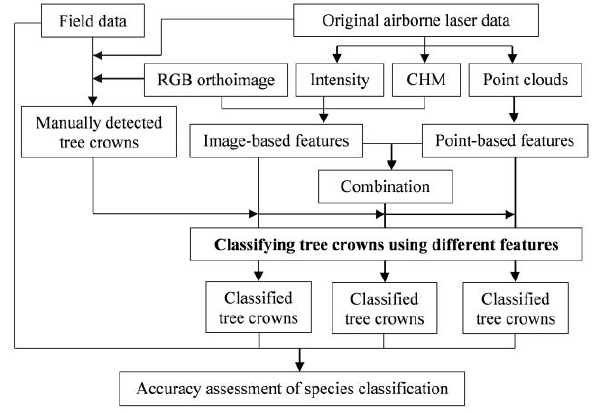
Figure 2. Research flow